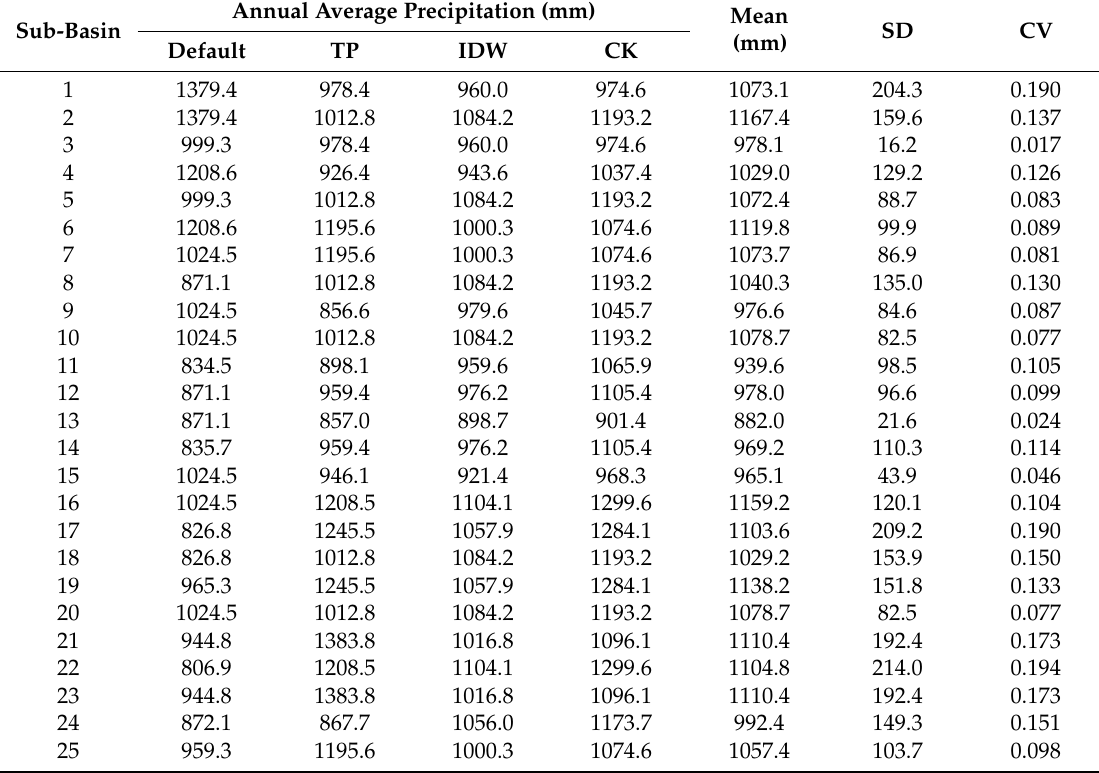
Table 2. The spatial rainfall variability in sub-basins and the areal rainfall input for each sub-basin.